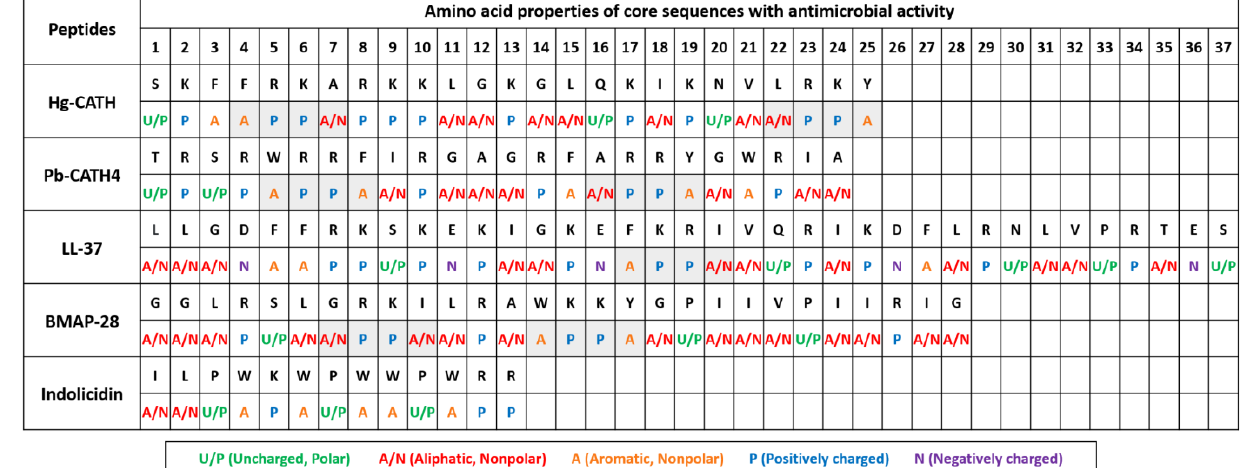
Figure 1. Comparison of the amino acid sequence and properties of five AMPs with anti-HSV-1 activity. Amino acid sequences of cathelicidins and chemical properties in different colours corresponding to each amino acid were shown. The definition of chemical properties was shown at the bottom. Numbers at the top indicate the position of amino acids. The conserved motif, A(A/N)-P-P-A(A/N), was highlighted in grey.